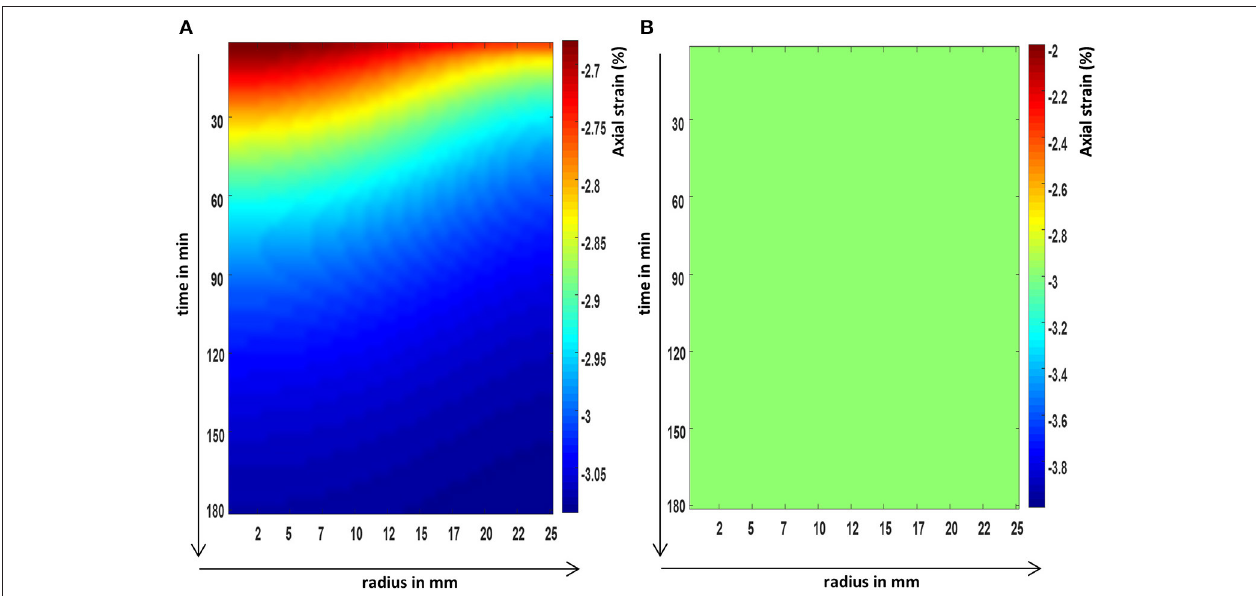
FIGURE 3 | The FEM predictions of the axial strain evolution over time, at the axial center, and across the radius of a cylindrical poroelastic sample subjected to a constant axial stress (A) and an equivalent constant axial strain (B) .